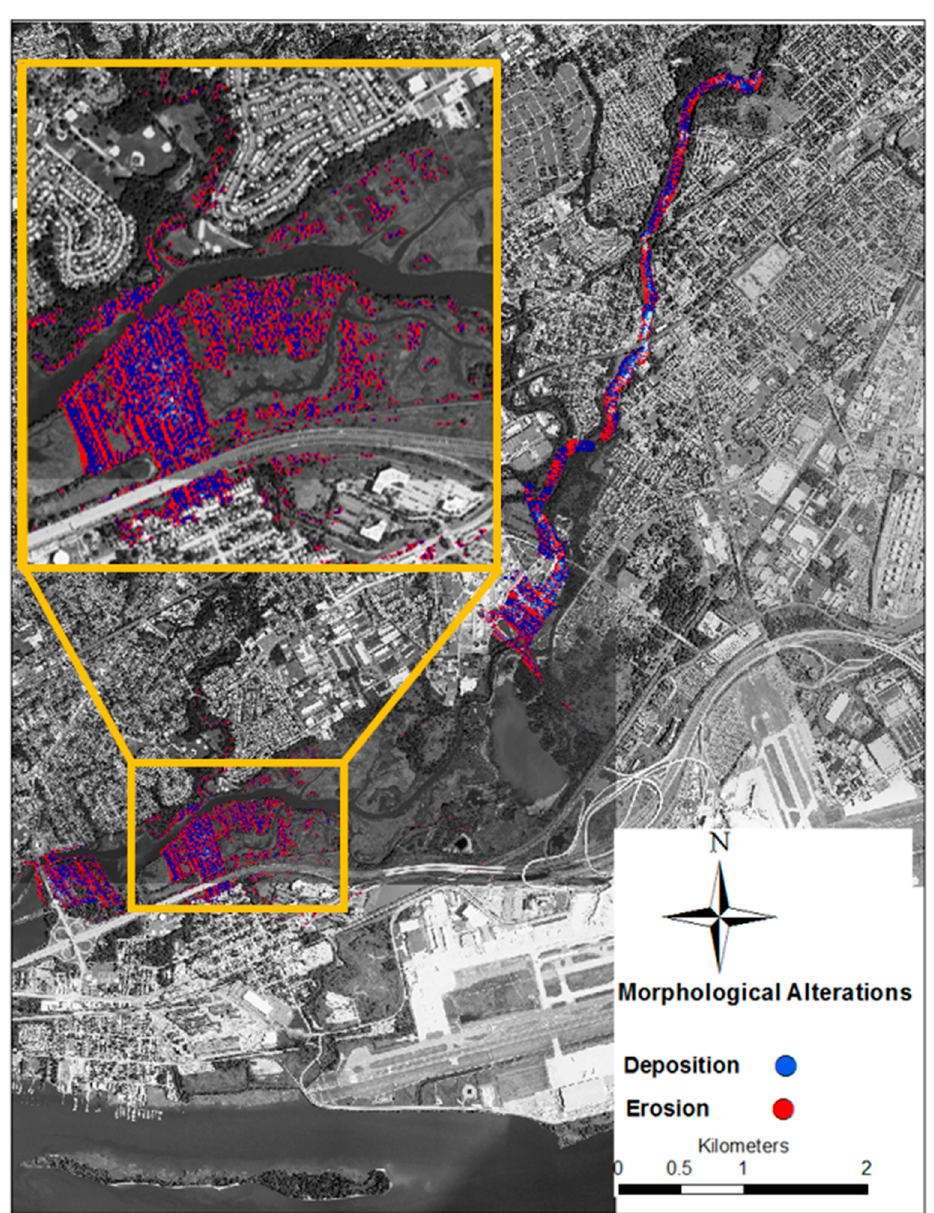
Figure 8. Erosion and deposition locations were identified by the integrated model for a discharge of 99 cms (USGS gage 01475548) with the duration of 1 h. Red and blue dots show where erosion and deposition were predicted.